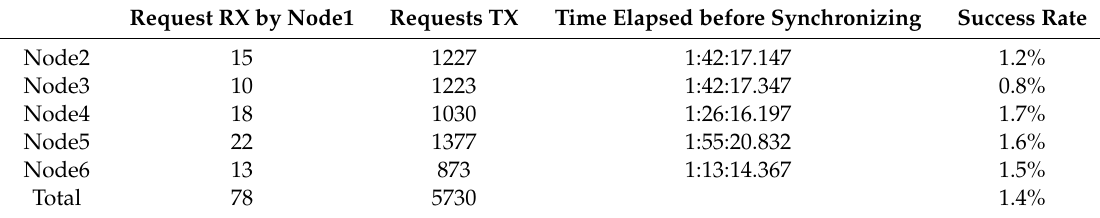
Table 1. Success rate for beacon request